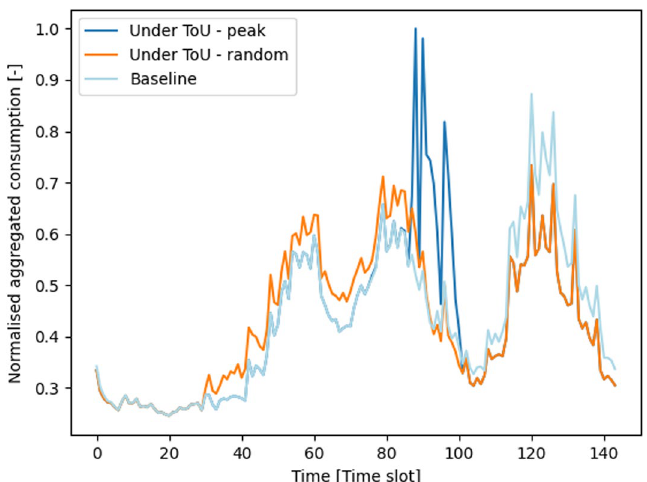
Fig. 16 Aggregated load trends: Baseline (e.g. Flat tariff) vs ToU tariff with behavioural change vs